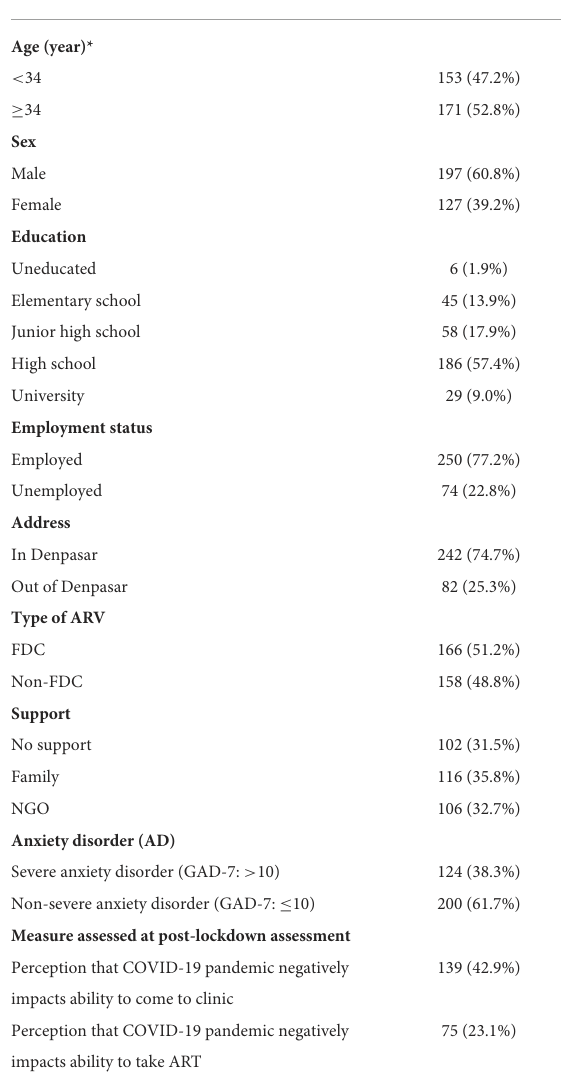
TABLE 1 Characteristic data of the participants ( n =